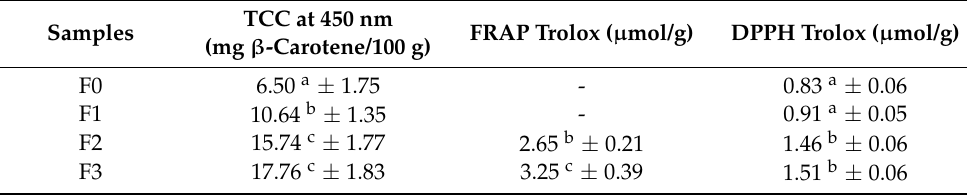
Table 6. Total carotenoid content (TCC) and antioxidant activity of muffins.